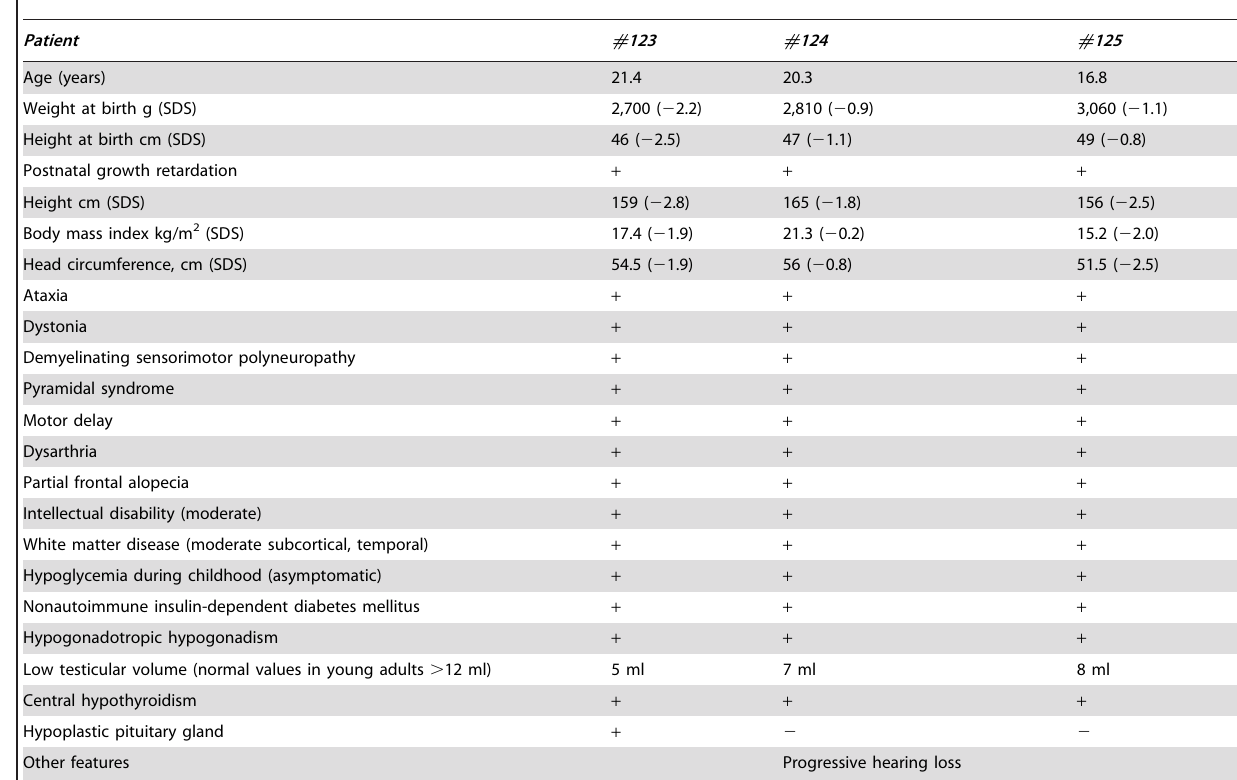
Table 1. Summary of the clinical phenotype of the three affected patients with DMXL2 mutations (see Figure 1 for patient numbering).